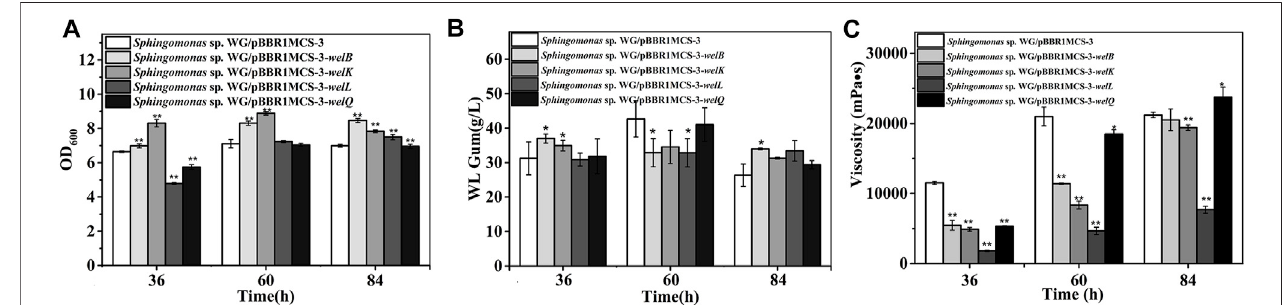
FIGURE 3 | Fermentation results of over-expression strain Sphingomonas sp. WG/pBBR1MCS-3- welB , Sphingomonas sp. WG/pBBR1MCS-3- welK , Sphingomonas sp. WG/pBBR1MCS-3- welL , Sphingomonas sp. WG/pBBR1MCS-3- welQ that contained genes involved in repeating unit assembly process. (A) Comparisonofbiomassofdifferentover-expressionstrains. (B) Comparison ofWLgumproductionofdifferentover-expressionstrains. (C) Comparisonoffermentation broth viscosity of different over-expression strains. The fermentation was preformed in 250 ml shaking fl asks containing 50 ml fermentation medium (67 g/L Glc, 3.4 g/Lyeastextract,0.1 g/LMgSO 4 ,3 g/LK 2 HPO 4 ,pH7.0),andculturedat32 ° C,150 rpmfor36,60and84 h.Thestrain Sphingomonas sp.WG/pBBR1MCS-3was used as the